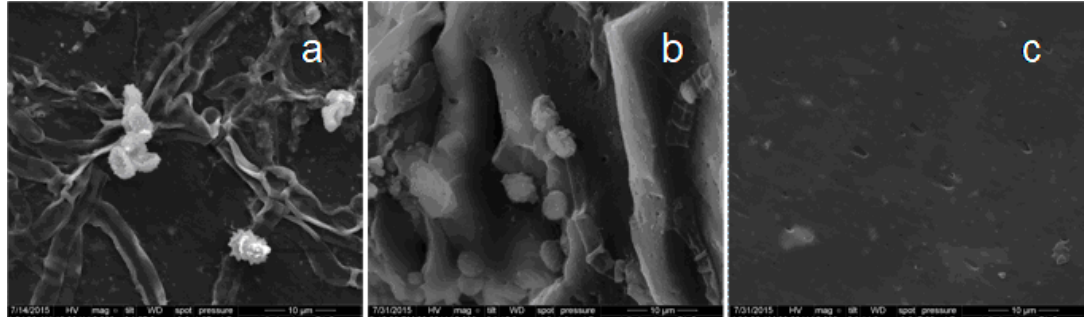
Figure 20. SEM of the C-1 composite. ( a ) after 60 days of incubation with Aspergillus niger ; ( b ) after 60 days of incubation with Aspergillus niger and after 72 h immersed in toluene; ( c ) the blanks (before incubation with the Aspergillus niger ) and after 72 h immersed in toluene.